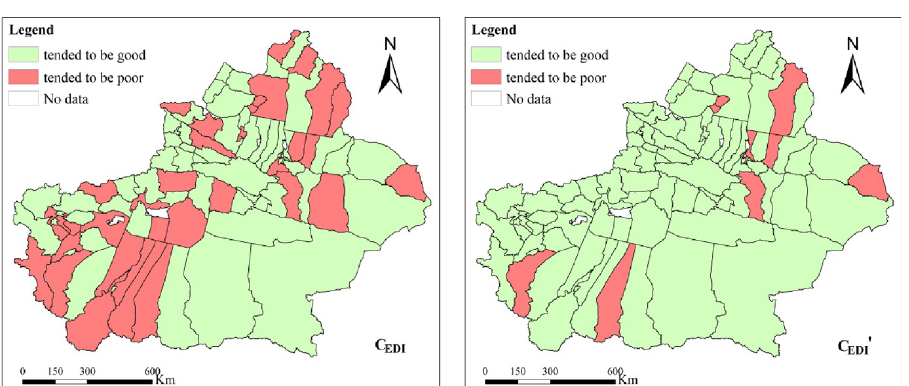
Fig 8. Comprehensive environmental depletion index (C EDI ) and EDI with EC corrected (C EDI ’).